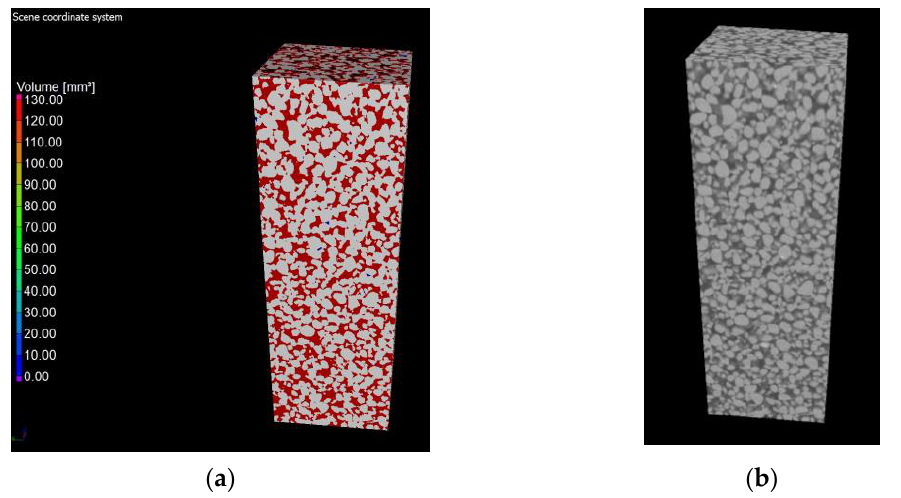
Figure 9. Cross-section through a sample of traditional sand-lime brick. ( a ) The pore content is marked in red;.( b ) Cross-section through a sample of sand-lime brick with a visible arrangement of SiO 2 , CaO grains and free spaces of different transparencies, shapes and